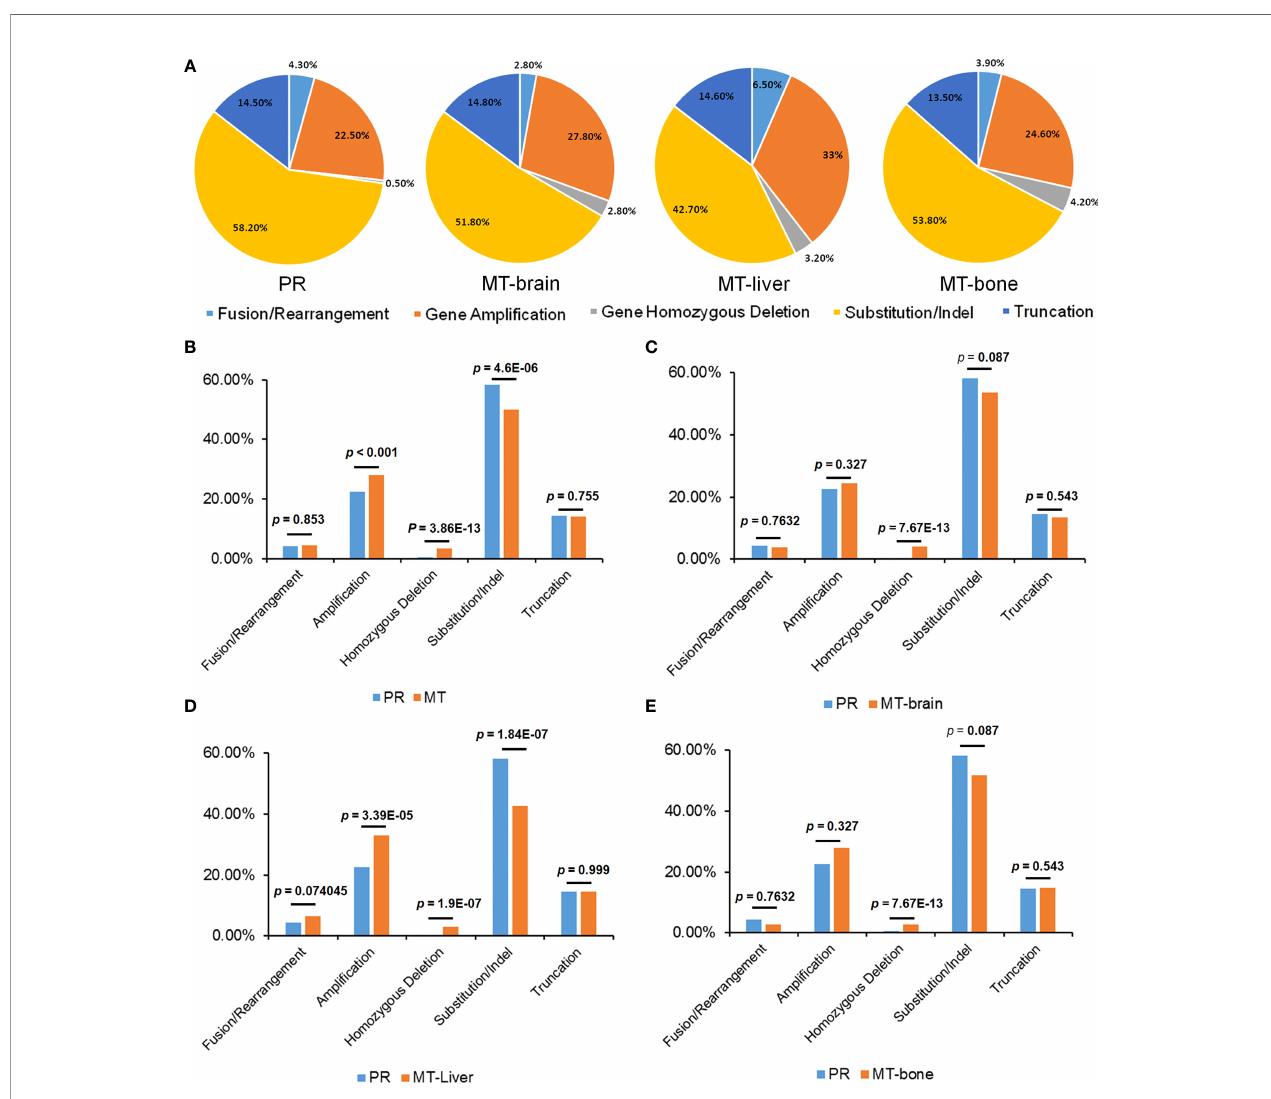
FIGURE 2 | The distribution of mutation types of primary tumors and metastases. (A) The percentages of different mutation types in PR and metastases. (B) A comparison of the proportions of mutation types between patients with PR and metastasis, (C) PR and MT-brain, (D) PR and MT-liver, and (E) PR and